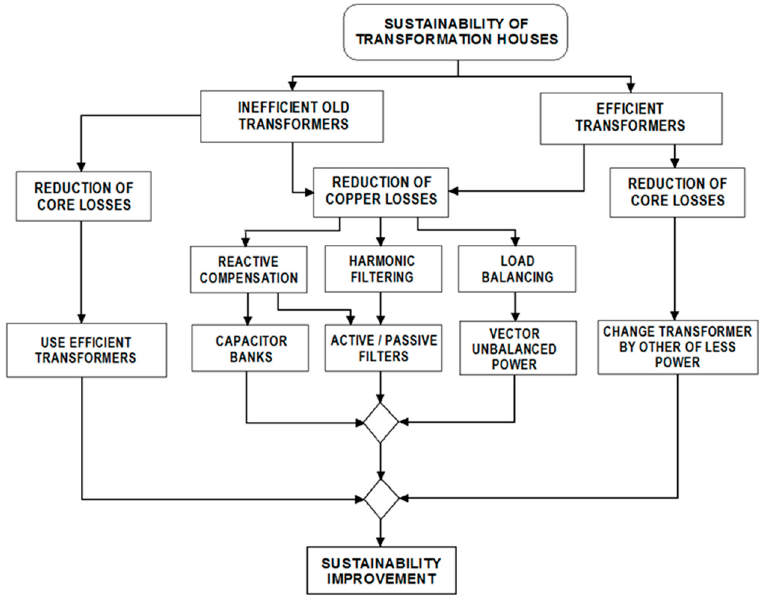
Figure 1. Organization chart of the procedure for improving the sustainability of transformation houses.